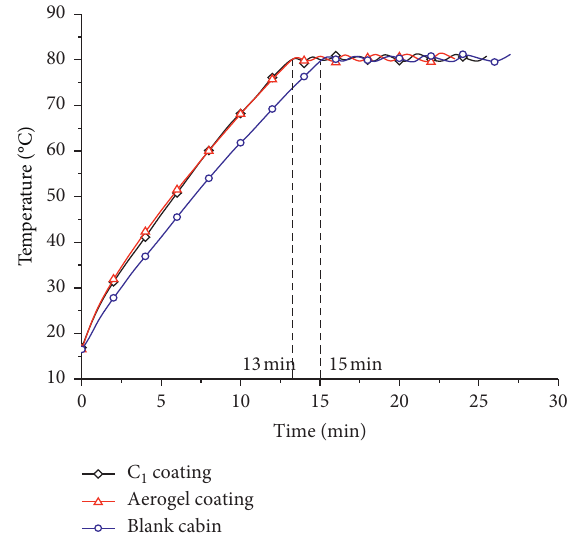
Figure 19: Integration test results of the thermally insulated coring